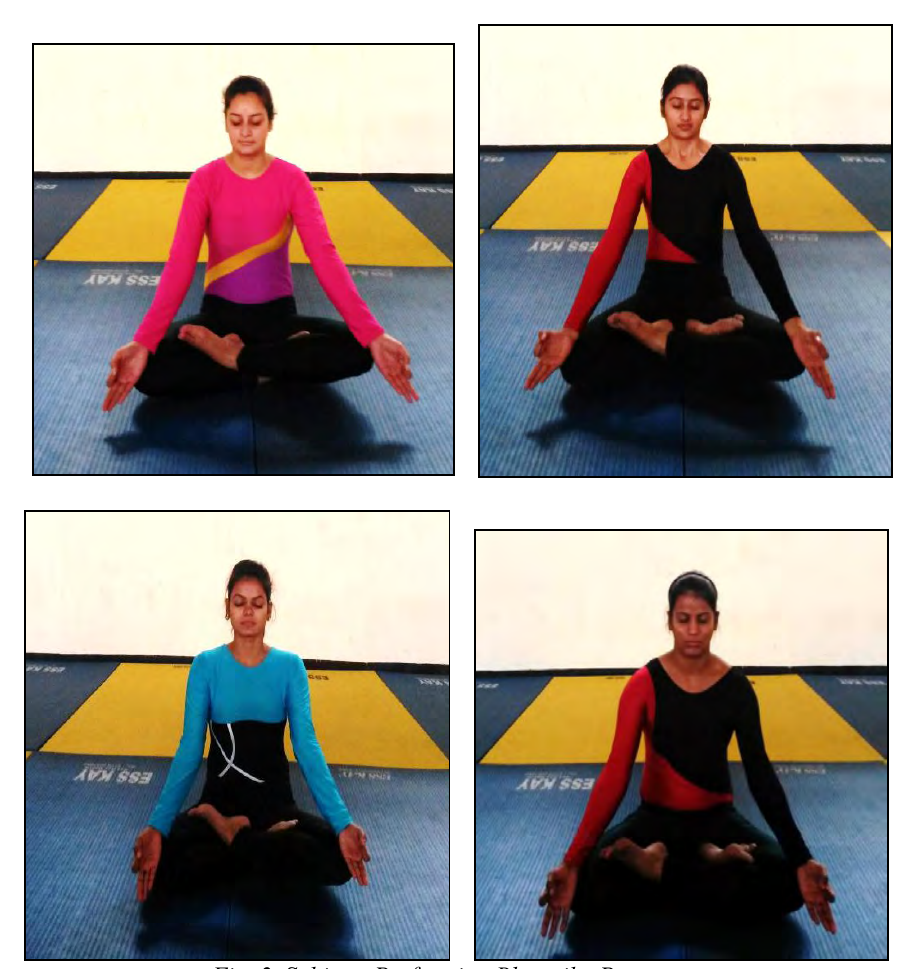
Fig. 2. Subjects Performing Bhastrika